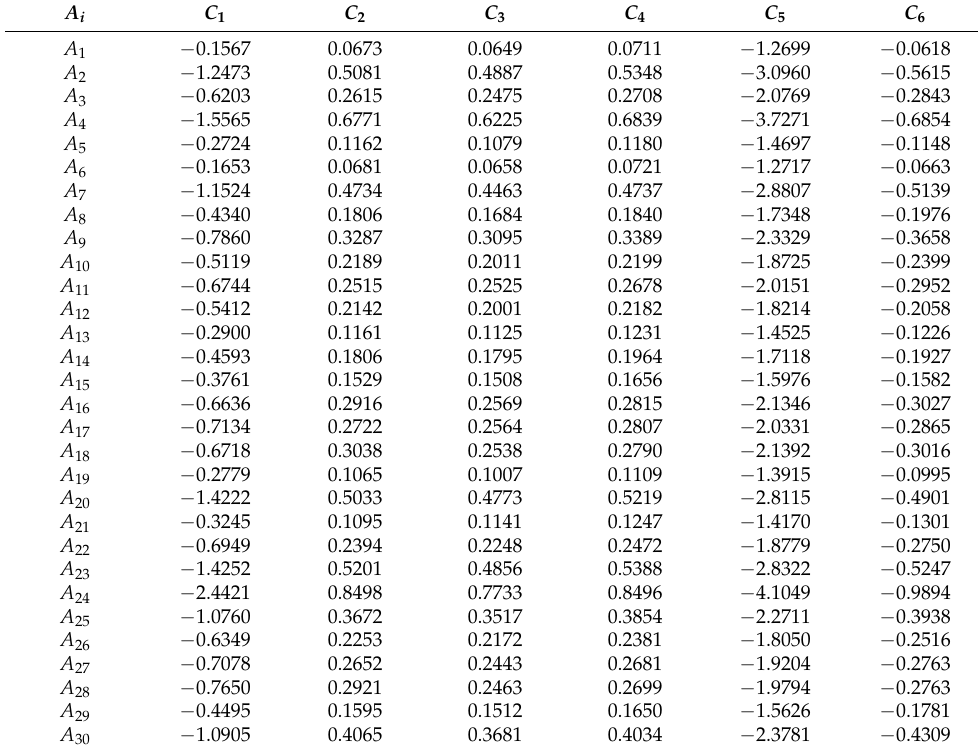
Table 7. Sensitivity analysis for SPOTIS.